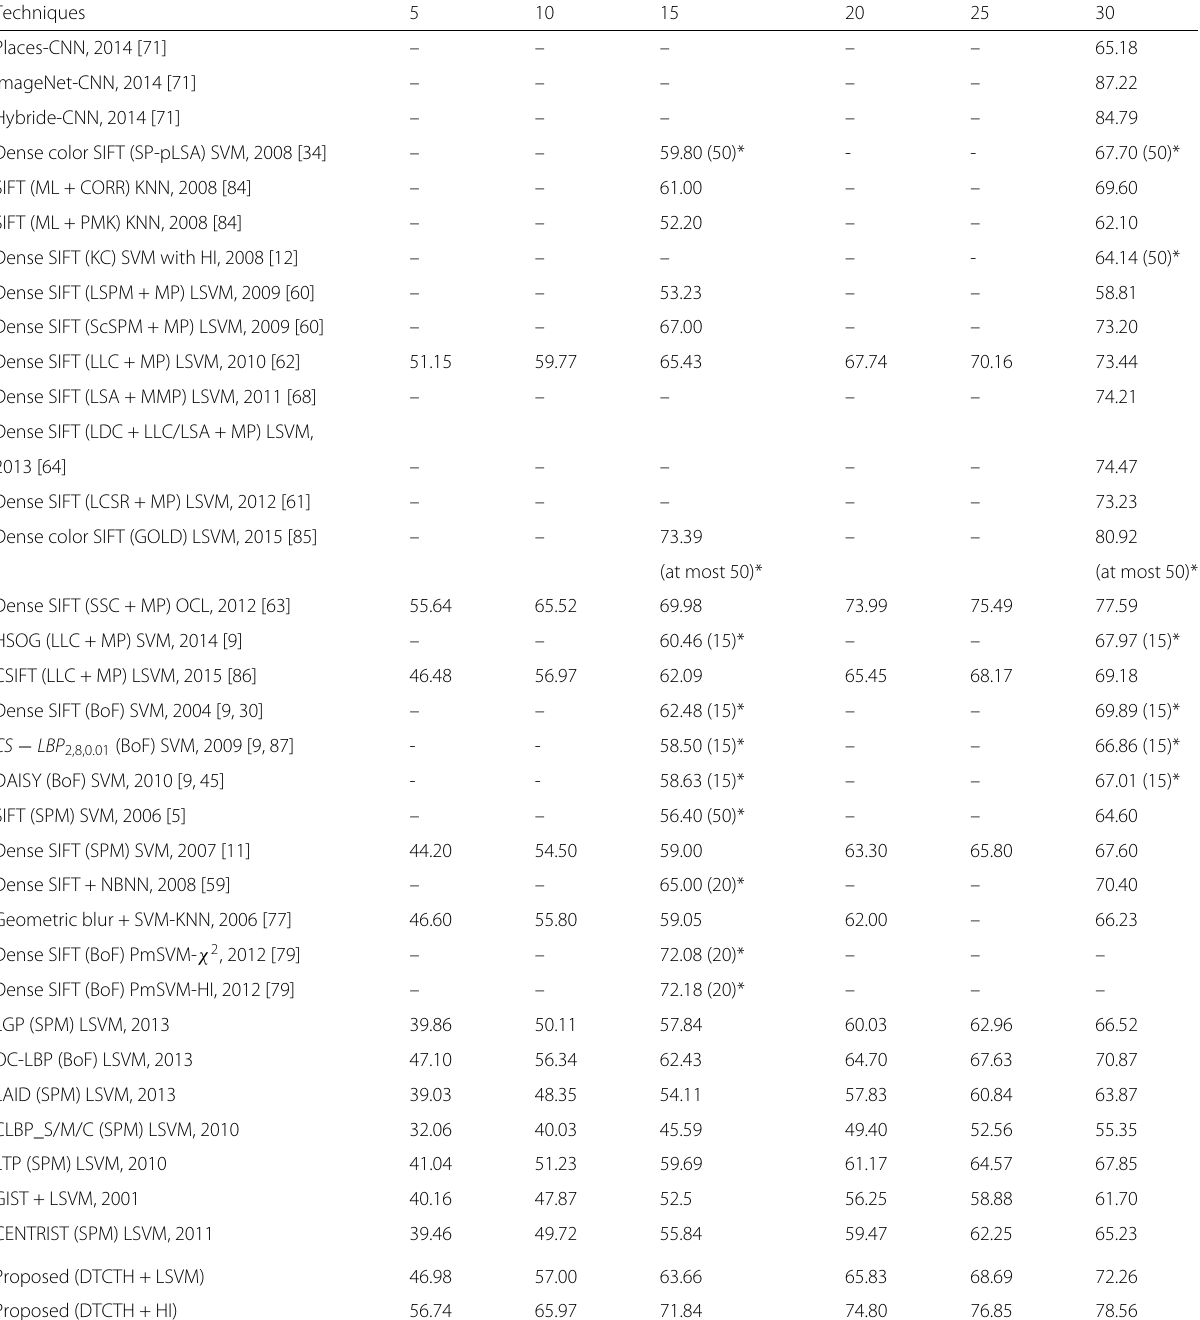
Table 3 Object classification rate (%) in